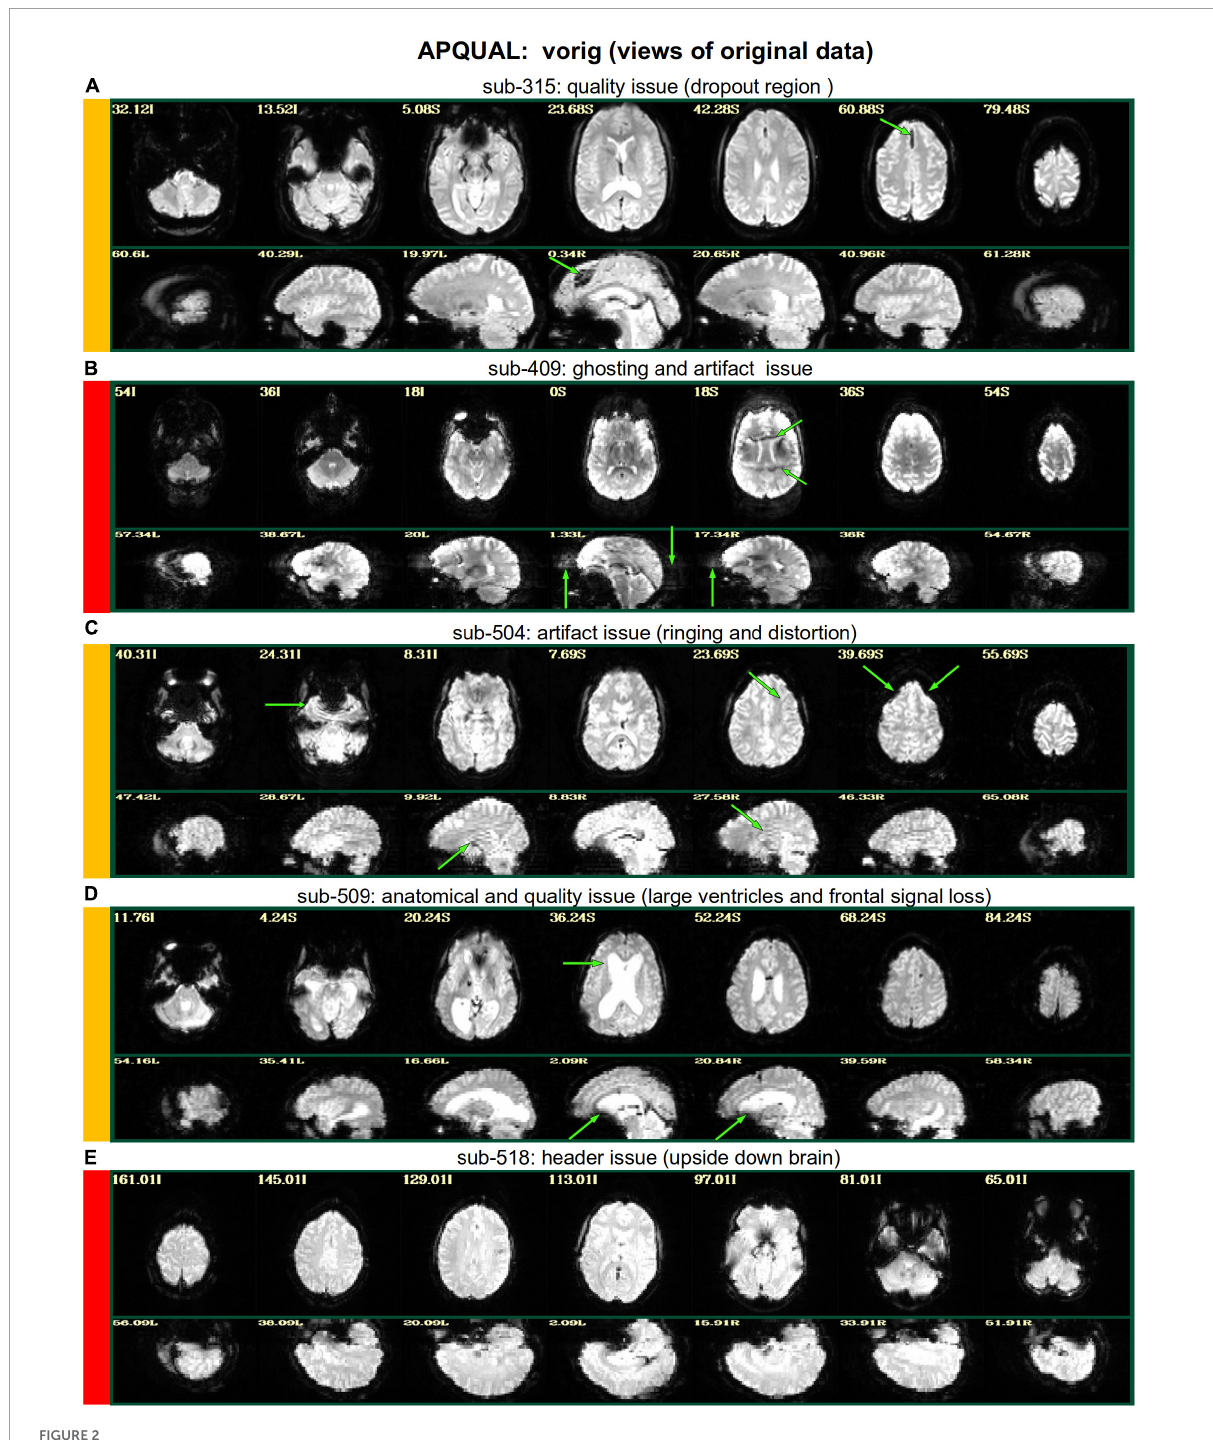
FIGURE2 APQUAL examples for the “vorig” QC block: Visualizations of the original datasets (here, just the EPIs). In this figure and below, the colored bands to the left of each item denote whether the given QC item would suggest that the subject should be excluded (red), included (green) or leads to an “uncertain” evaluation (yellow); also, see Table 3 for brief, overall evaluations for each subject, and the Supplementary Table 1 for detailed QC comments. (A) The EPI contains a moderately sized dropout region (but it is mostly contained within the central sulcus). (B) This EPI contains severe ghosting artifact. (C) The inferior slices show a ringing artifact, and the frontal region is geometrically distorted. (D) This subject’s large ventricle may negatively affect alignment to template space, and there is notable dropout in the orbitofrontal region and subcortex. (E) The EPI is upside down, a significant header or data conversion